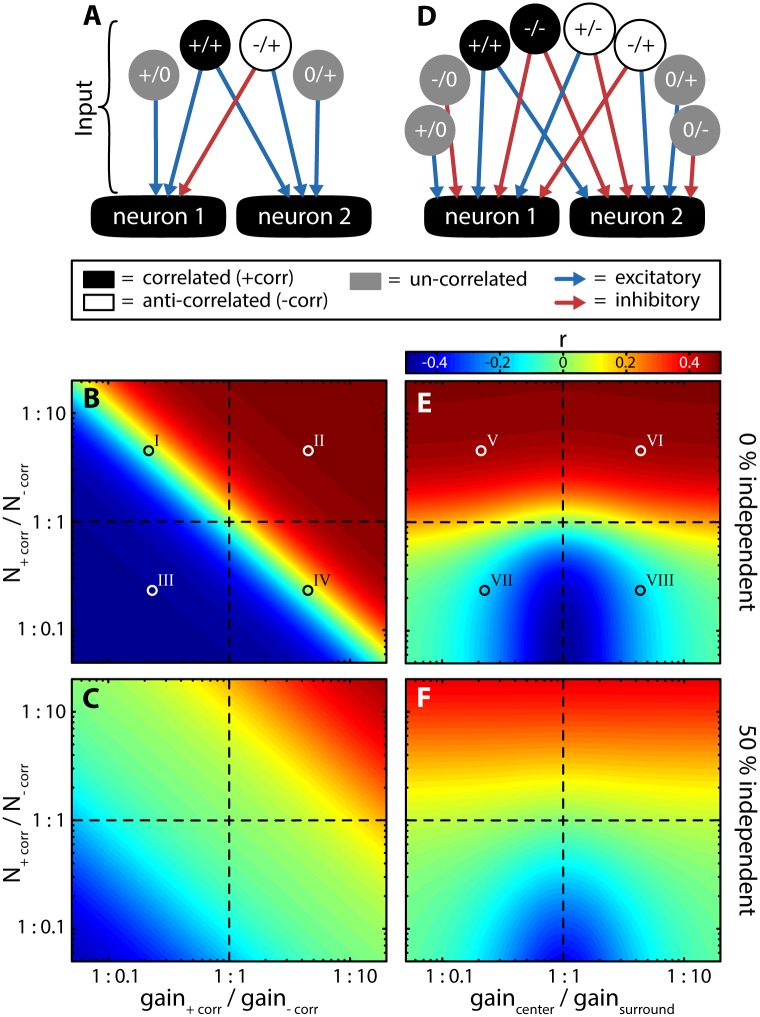
Effects of the different portions of RF interactions on correlated activity using arbitrary RF geometries.(A) Three types of inputs to two putative neurons were considered: (1) correlated input (black; same sign; +/+); (2) anti-correlated input (white; opposite sign; -/+); and (3) uncorrelated input (gray; +/0 & 0/+). The inputs were mapped onto the neurons either in an excitatory (blue arrows) or inhibitory (red arrow) fashion. (B & C) For a fixed total input (Ntot = 1000), the ratio of correlated and anti-correlated inputs was varied in terms of both their amount (N+corr / N-corr) and in terms of their gain (gain+corr / gain-corr). This was carried out for different but fixed portions of uncorrelated inputs (shown are 0% in B and 50% in C). Roman numerals (I–IV) depict cases for which the inputs are illustrated in S10A Fig
(D) Expanded model in which all possible types of RF interactions were considered: correlated inputs (+/+ & -/-), anti-correlated inputs (+/- & -/+) and uncorrelated inputs (+/0, -/0, 0/+, & 0/-). These were mapped onto the downstream neurons either excitatory (blue arrows) or inhibitory (red arrows) depending on whether a given input was part of the RF center of the RF surround. (E & F) As (B & C), but when independently varying gaincenter / gainsurround depending on whether an input was part of the RF center or surround. Roman numerals (V–VIII) depict cases for which the inputs are illustrated in S10B Fig.